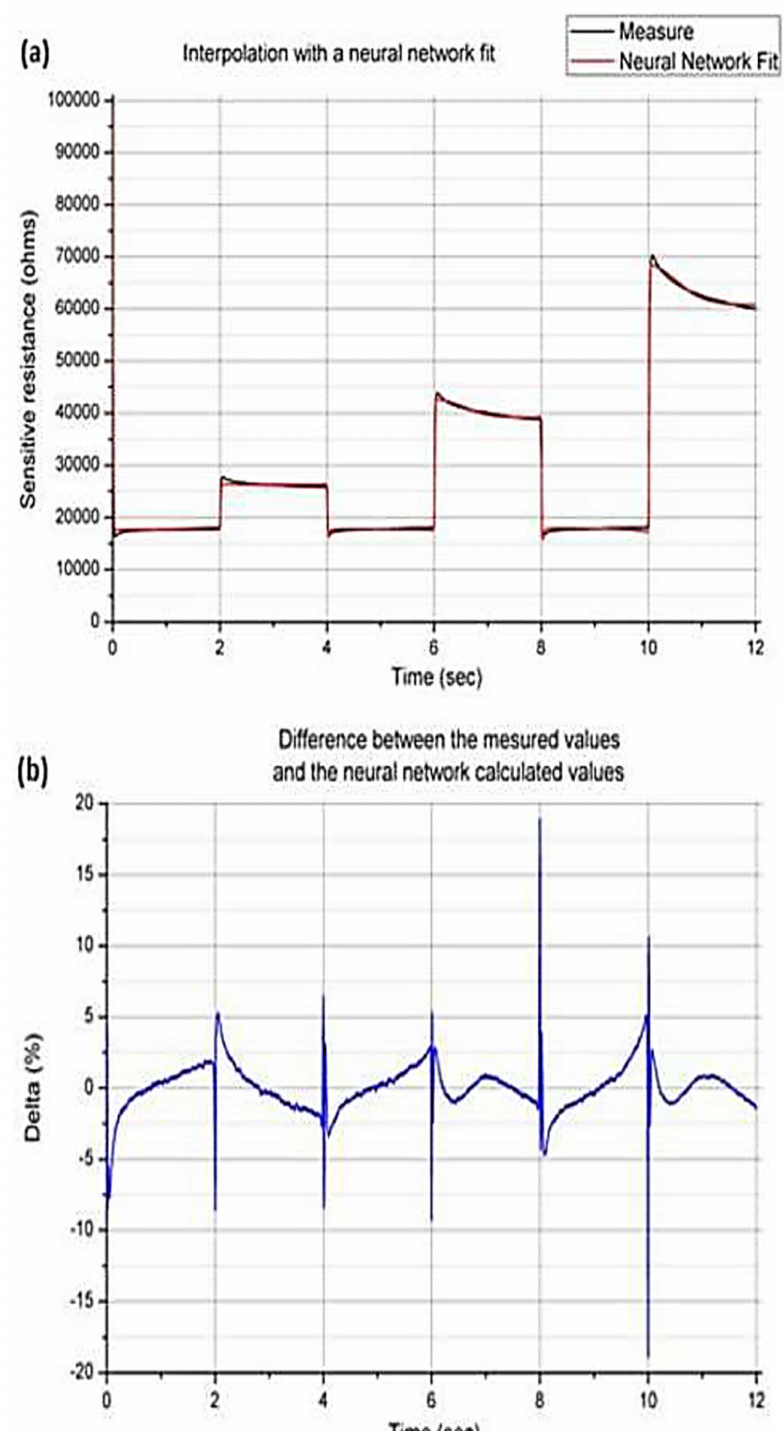
Figure 7. Comparison between the sensor’s response and the neural network modeling (with 50 hidden neurons) ( a ) and difference between both ( b